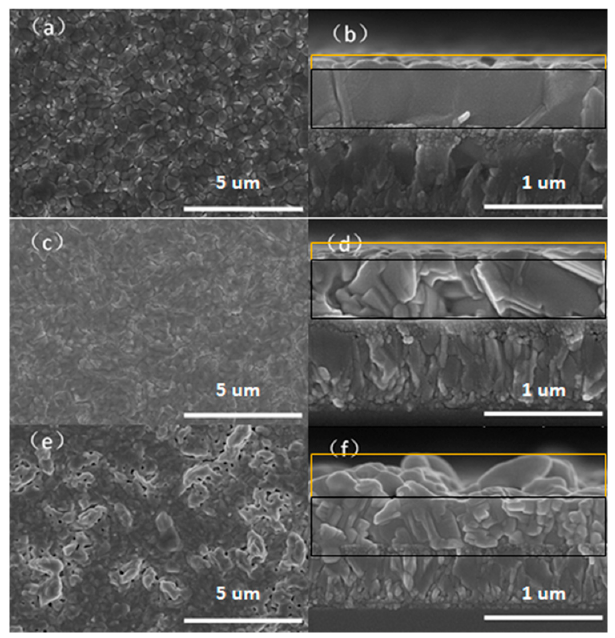
Figure 1. Top view ( a , c , e ) and cross-sectional view ( b , d , f ) with different delay times: ( a , b ) 0 s; ( c , d ) 5 s; ( e , f ) 10 s.